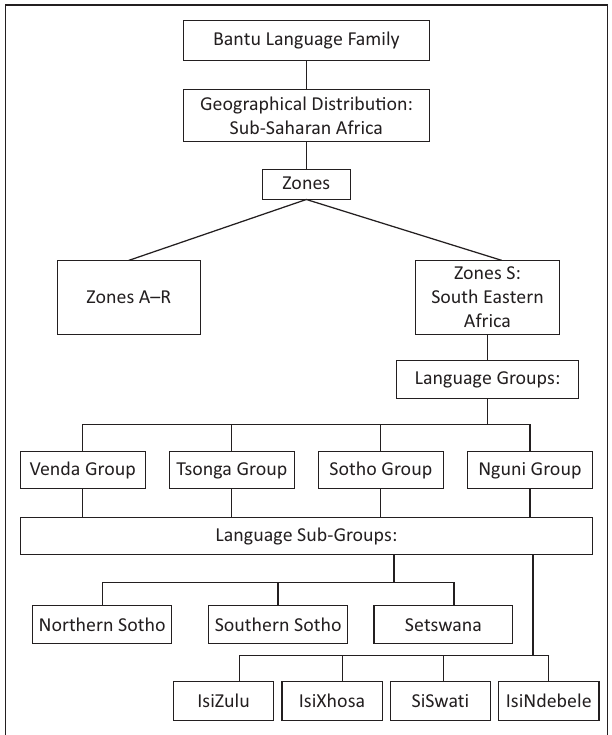
FIGURE 1: Language groups found in the south-eastern zone of Africa, with special reference to the Nguni and Sotho sub-groups.